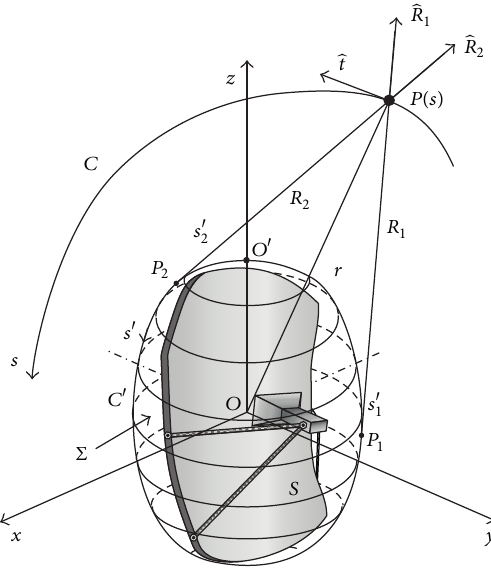
Figure 4: Relevant to a meridian observation